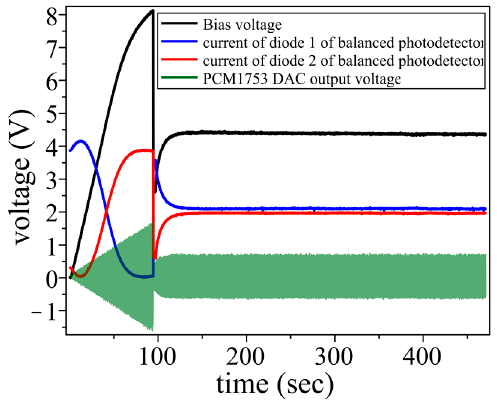
Figure 7. Start-up of bias point stabilization.